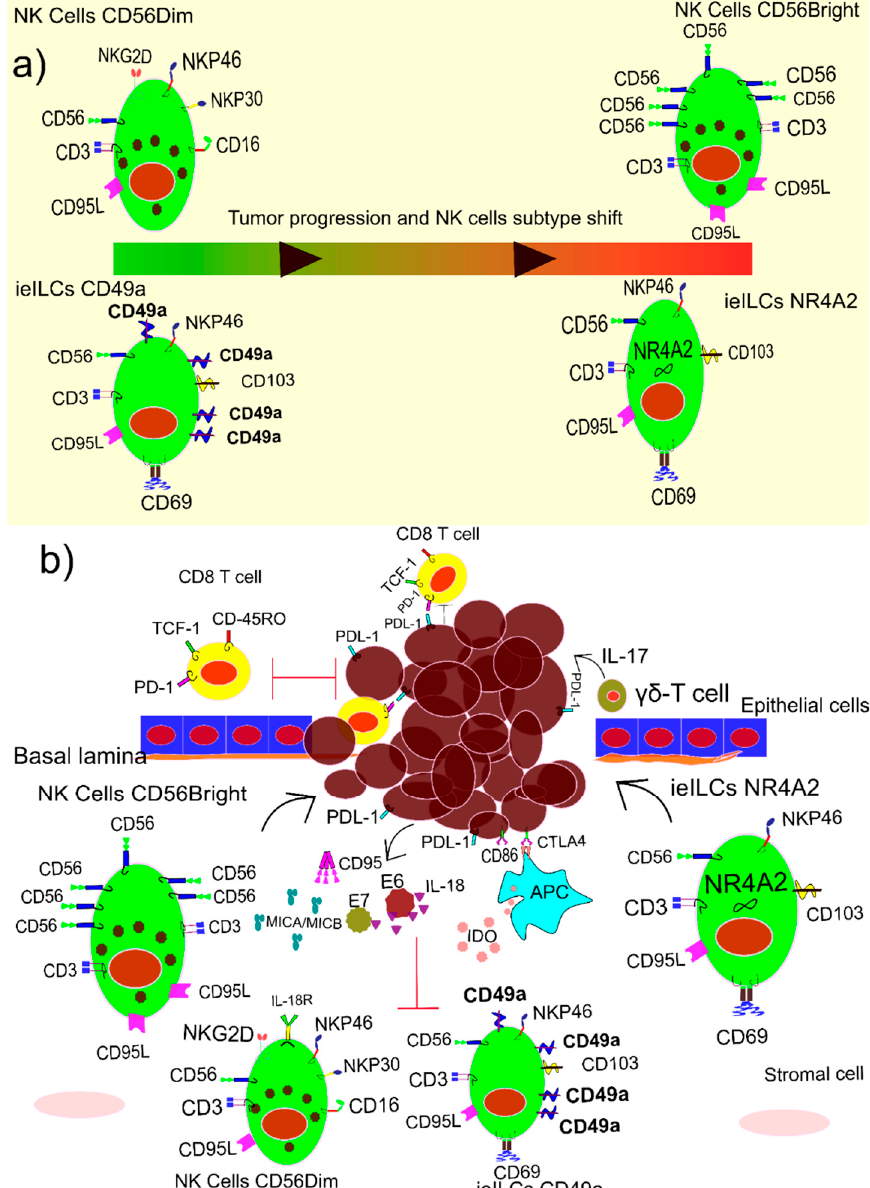
Figure 4. ( a ) The quantity of NK cells in HPV-related cancer does not change. However, there is